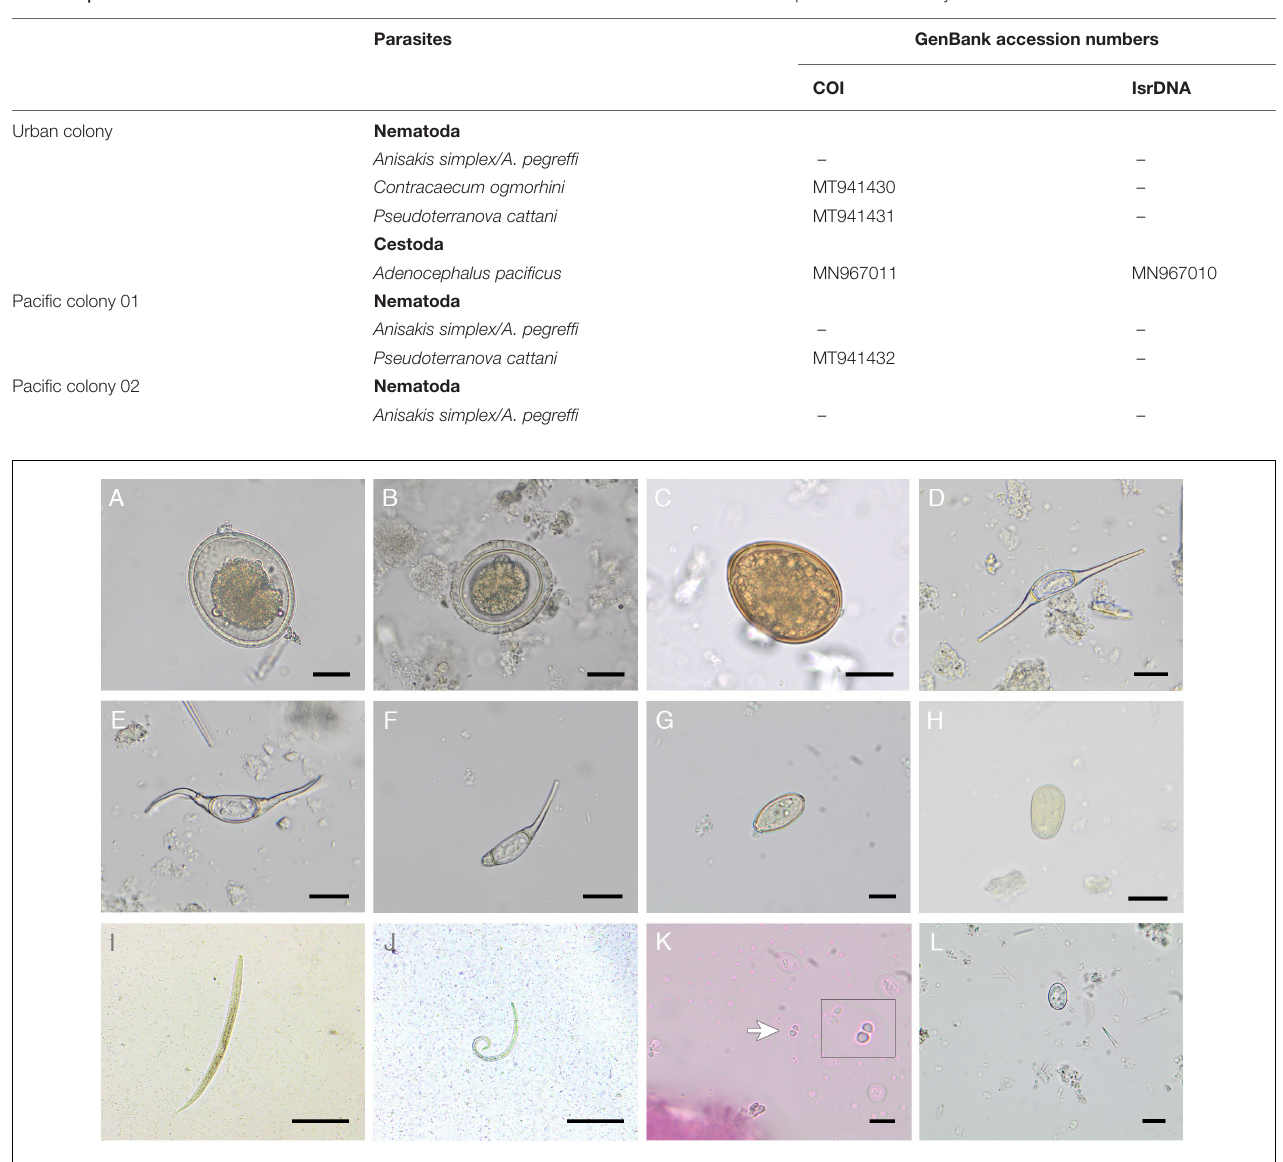
FIGURE 4 | Illustration of metazoan and protozoan parasite stages detected within this study. Eggs of (A,B) Anisakidae gen. spp. varying in shell thickness, (C) Diphyllobothriidae gen. spp., Ogmogaster heptalineatus showing (D) intact morphology, (E) flexibility of filaments and (F) broken filament, (G) Trematoda indet. type 1, and (H) Trematoda indet. type 2. First-stage larvae of (I) Otostrongylus circumlitus and (J) Parafilaroides spp. (K) Cryptosporidium spp. oocysts, (L) Giardia spp. cyst. Scale bars: (A–H) 20 µ m, (I,J) 100 µ m, (K,L) 10 µ